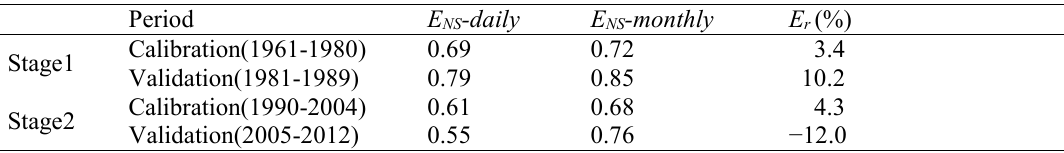
Fig. 2 Comparison of VIC-simulated and observed hydrograph at the Xianyang hydrological station. Table 2 Results of the VIC staging calibration and validation.